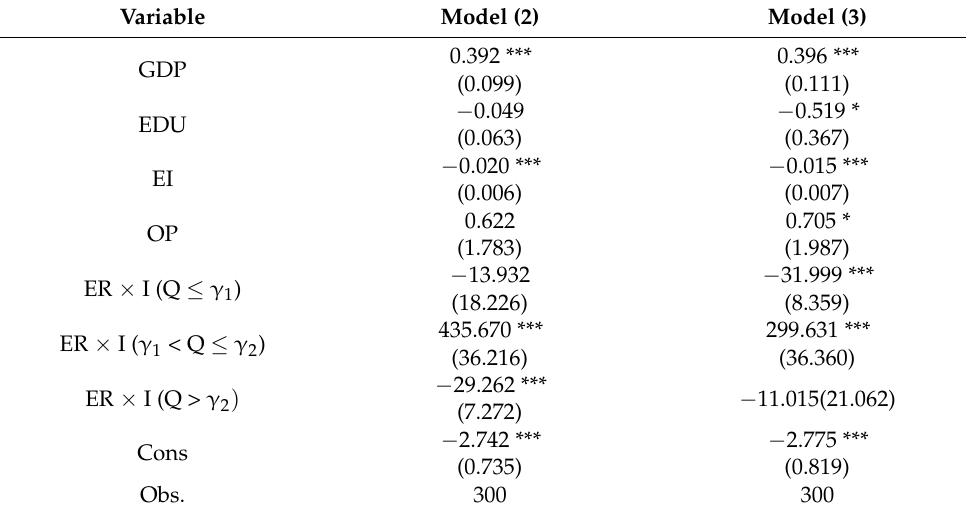
Table 7. Estimation results of panel threshold